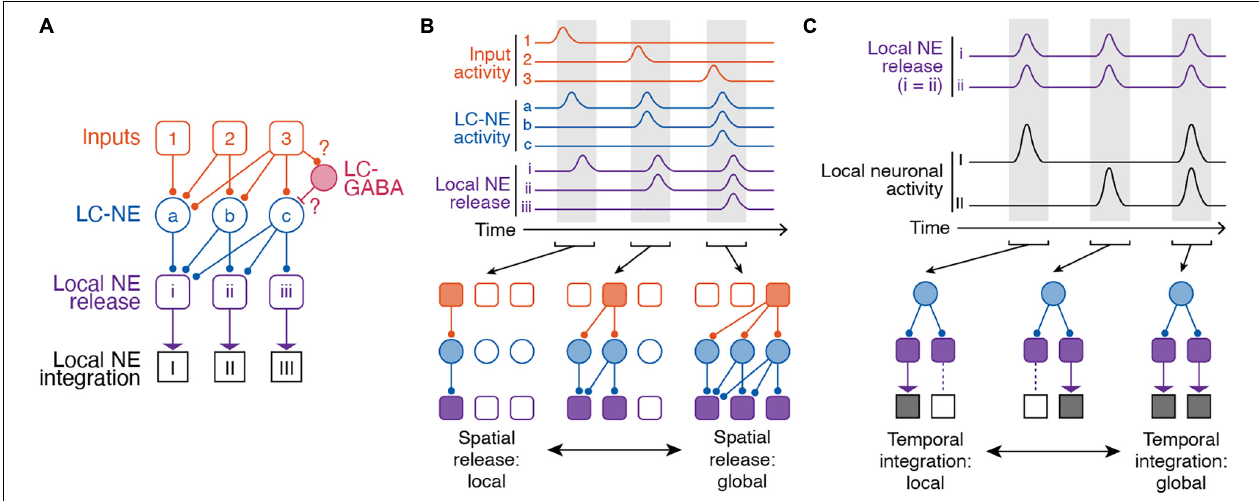
FIGURE 3 | Spatiotemporal dynamics of the LC-NE system. (A) Anatomical organization of inputs to and outputs of LC. Note, LC-GABA neurons were included in this illustration as potential mechanism for nuancing local LC-NE activity, but, so far, no data exist on the relationship between local LC-GABA and specific LC-NE outputs. (B) Spatial modularity of LC-NE release. Top – Example activity of inputs to LC-NE neurons (orange), LC-NE neurons (blue), and local LC-NE release (purple). Bottom – Local versus global release of NE in output regions is dependent on which LC-NE neurons are activated by a given input. (C) Temporal modularity of LC-NE neuromodulation. Top – activity of local NE release in two given output regions and underlying neuronal activity in each region. Note, we assume that NE release is spatially global for simplicity. We also assume that NE neuromodulation increases neuronal activity in both target regions. Bottom – Due to differential NE receptor expression in brain regions, heterogenous expression of NE receptors on different types of brain cells, or the underlying function of a specific brain region, temporal integration can be local or